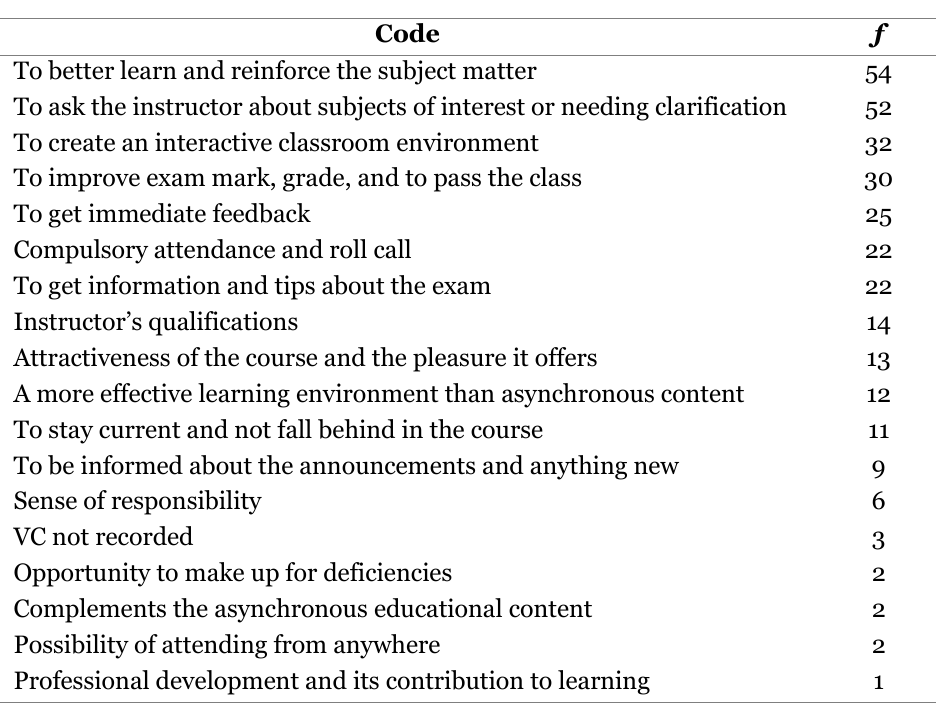
Reasons for Attending VCs and Frequency of Response